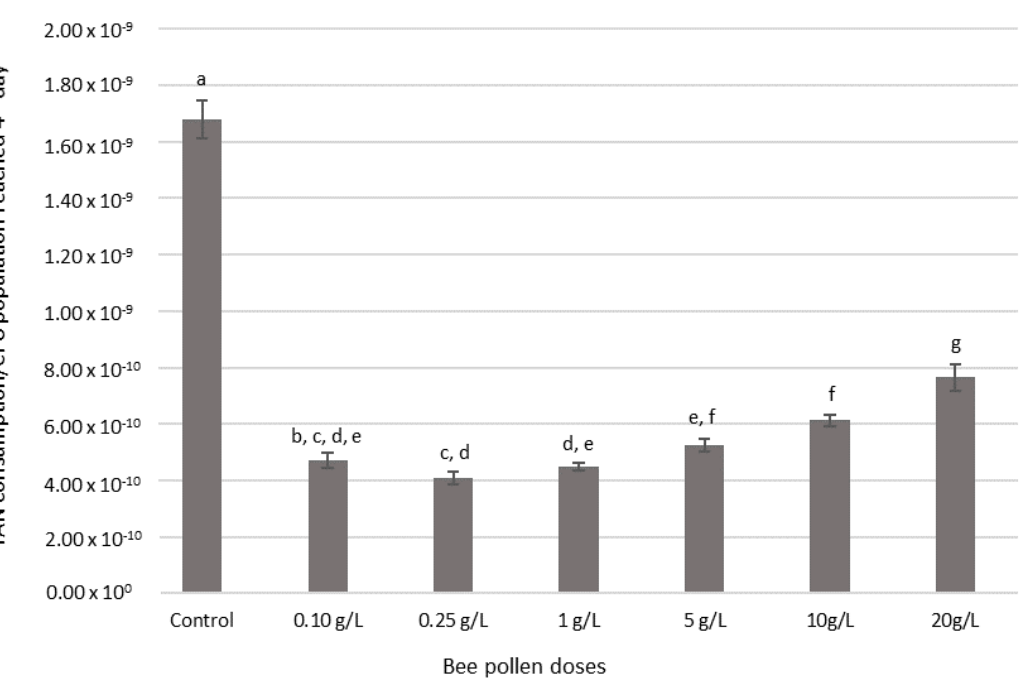
Figure 6. YAN/CFU consumption during the exponential growth phase of fermented Tintilla de Rota grape-must with different doses of multiflora bee pollen. Di ff erent letters mean significant di ff erences between samples (ANOVA, p <